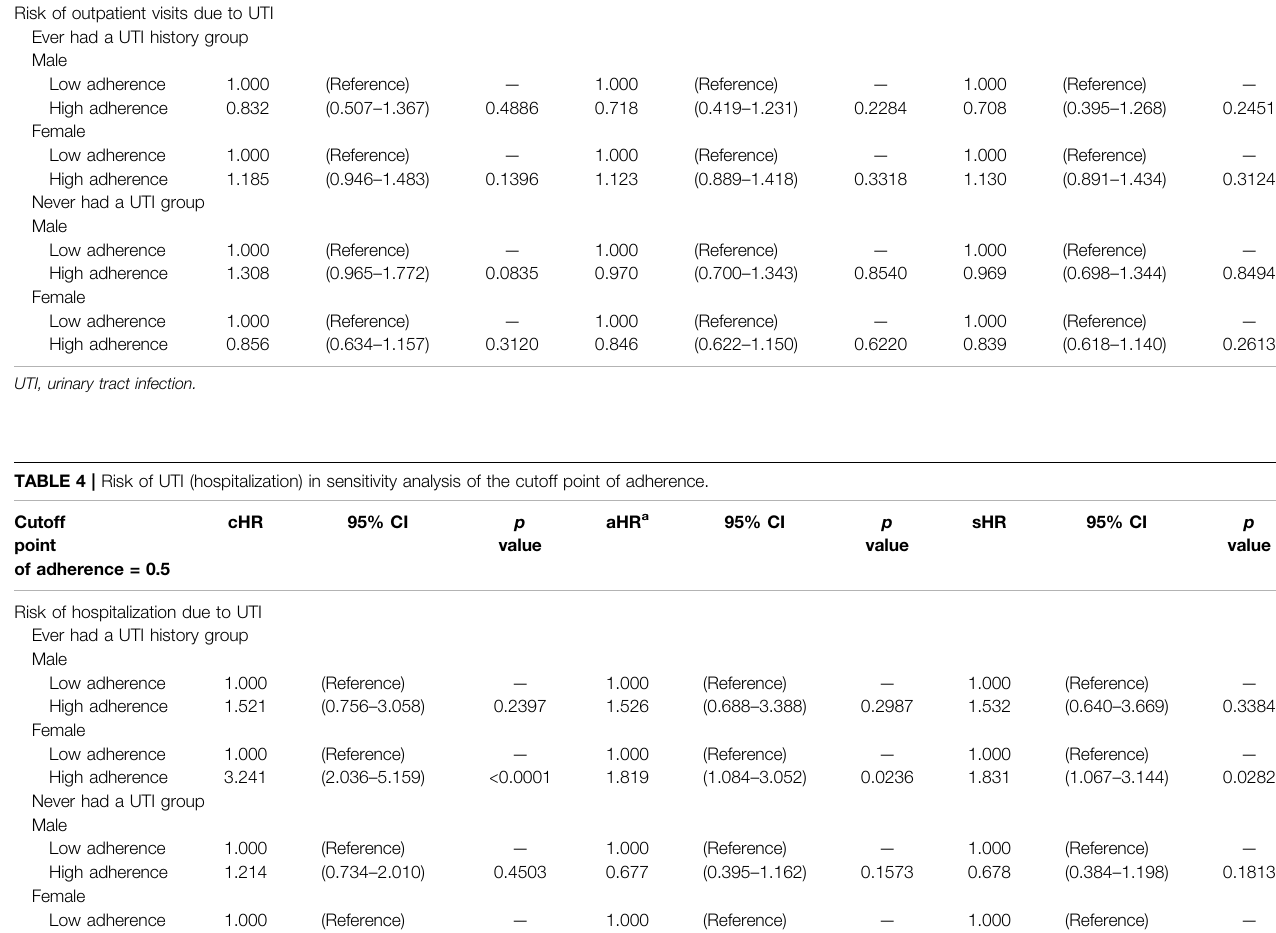
TABLE 3 | Risk of UTI (outpatient) in sensitivity analysis of the cutoff point of adherence. Cutoff point of adherence = 0.5